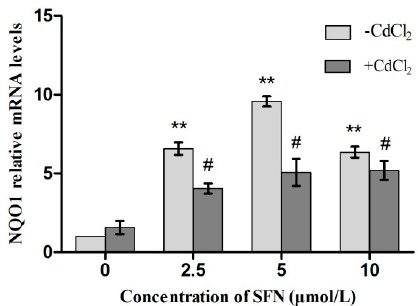
Figure 14. Effects of SFN on Cd induced the relative mRNA expression of Nrf2, GSH-Px, HO-1, γ -GCS, and NQO1 of TM3 cells. * and ** represent a significant and an extremely significant difference, respectively, compared with the control group. # and ## represent a significant and an extremely significant difference, respectively, compared with the Cd group.